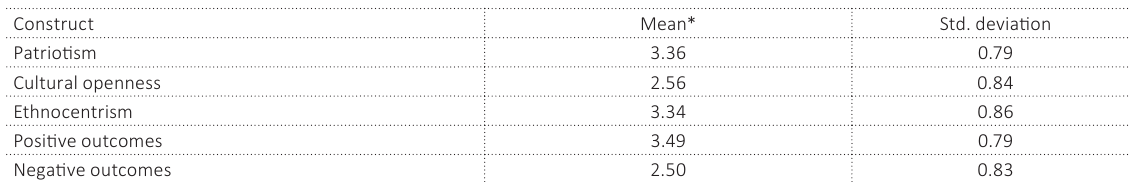
Table 4. Mean comparison for